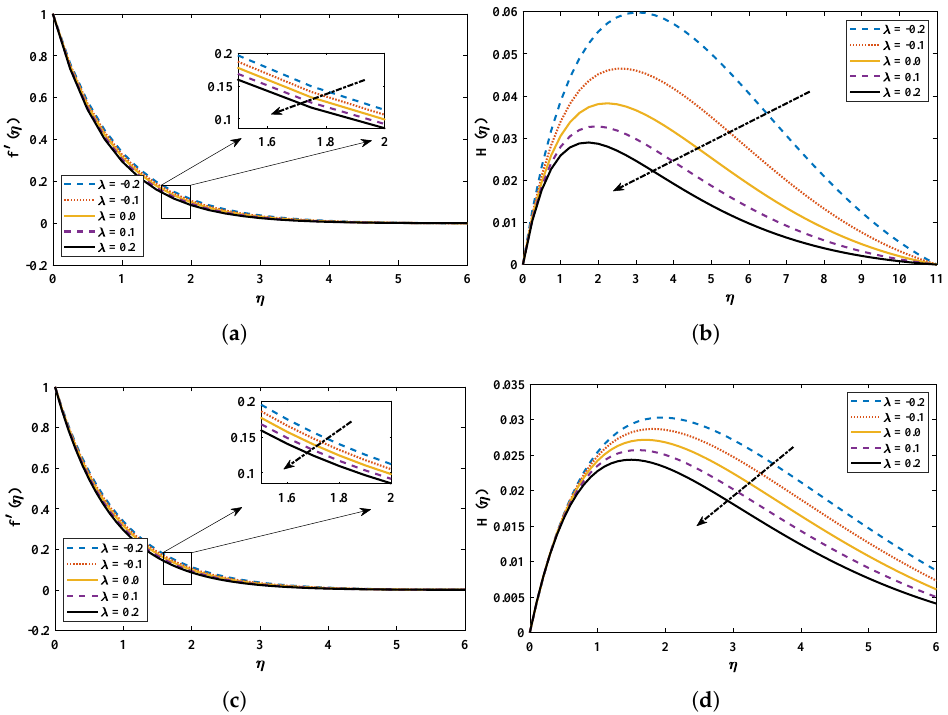
Figure 8. Graphical study of the influence of variations in the suction/injection parameter on the velocity and micro-rotation of the fluid: ( a , b ) isothermal boundary conditions and ( c , d ) isoflux boundary conditions.